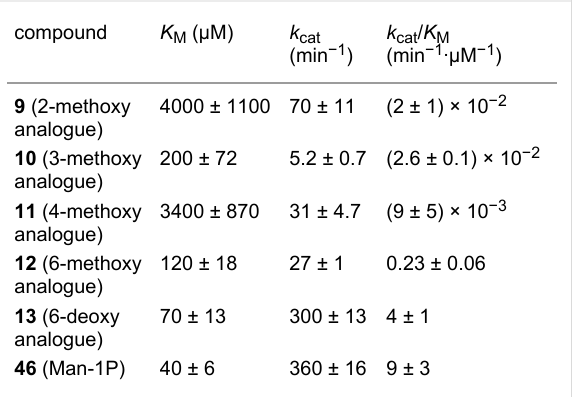
Table 1: K M , k cat , and k cat / K M of GDP-ManPP kinetic